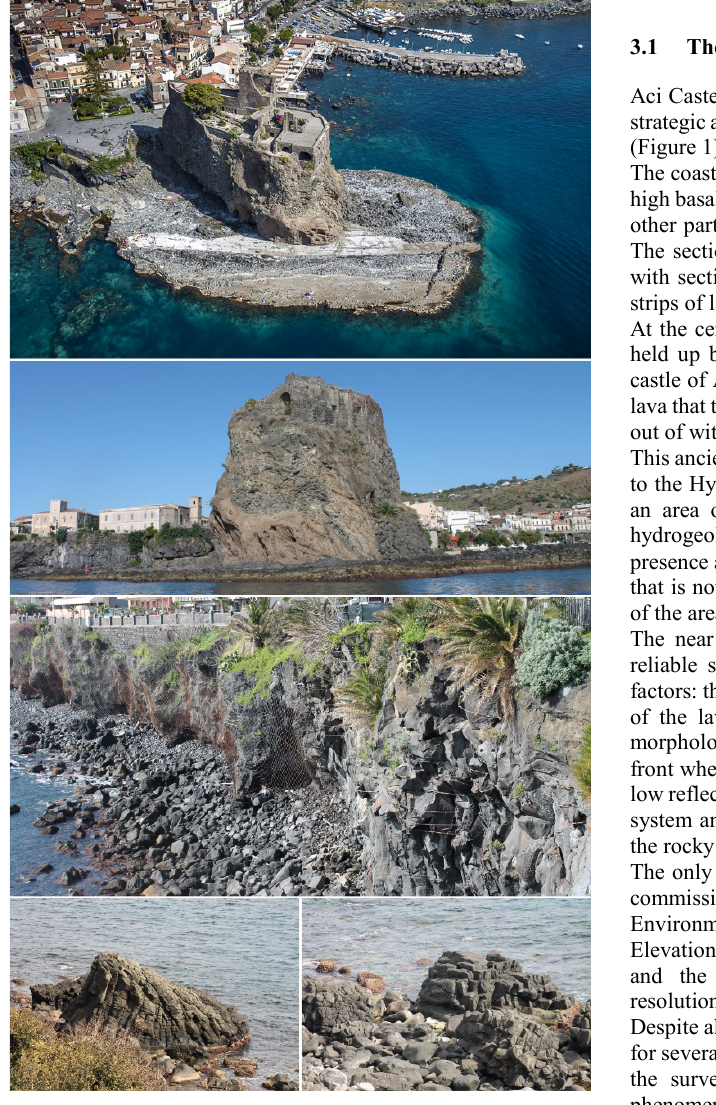
Figure 1: Aci Castello, images of the morphological articulation of the lava coastline and of the Aci castle (Luigi Nifosi) with road side acquisition, often aimed at expedited updating of data predominantly onto cartography. However, what is worth mentioning is the experimentation carried out a few years ago in Venice for a study of the facades of the architectural patrimony that overlooks the Grand Canal, by mounting a system of mobile mapping onto a boat. (Adami et al., 2011) This experiment though did not deal with the survey of the submerged part of the Grand Canal. For this reason, the bathymetric studies, related to both echo sounder (Perzia et al., 2011) and Lidar (Chust et al., 2010) survey techniques, are of great interest. Taking into account the experience gained both nationally and internationally, an experimentation was developed for the coastal site of Aci Castello, geared towards integrating various survey techniques. The possibility to survey the coasts by taking advantage of the sea - that up until now had seemed a limit - was an opportunity to test. The aim of the integrated survey was to obtain a 3D model capable of analysing and documenting a coastal site, in line with different scientific themes and